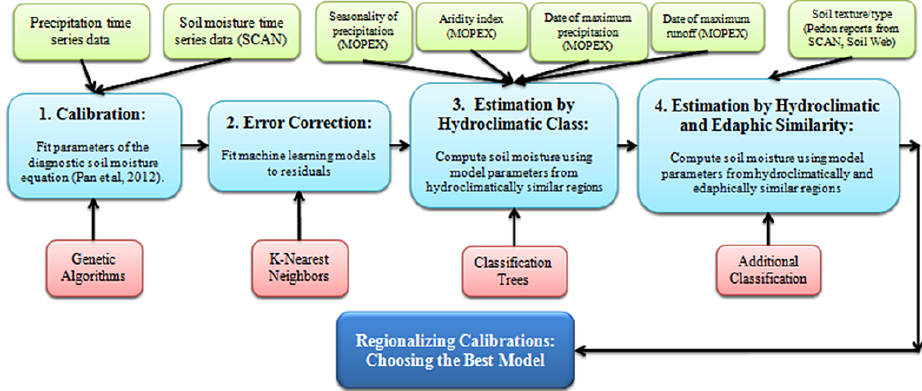
Figure 1. Methodological flow